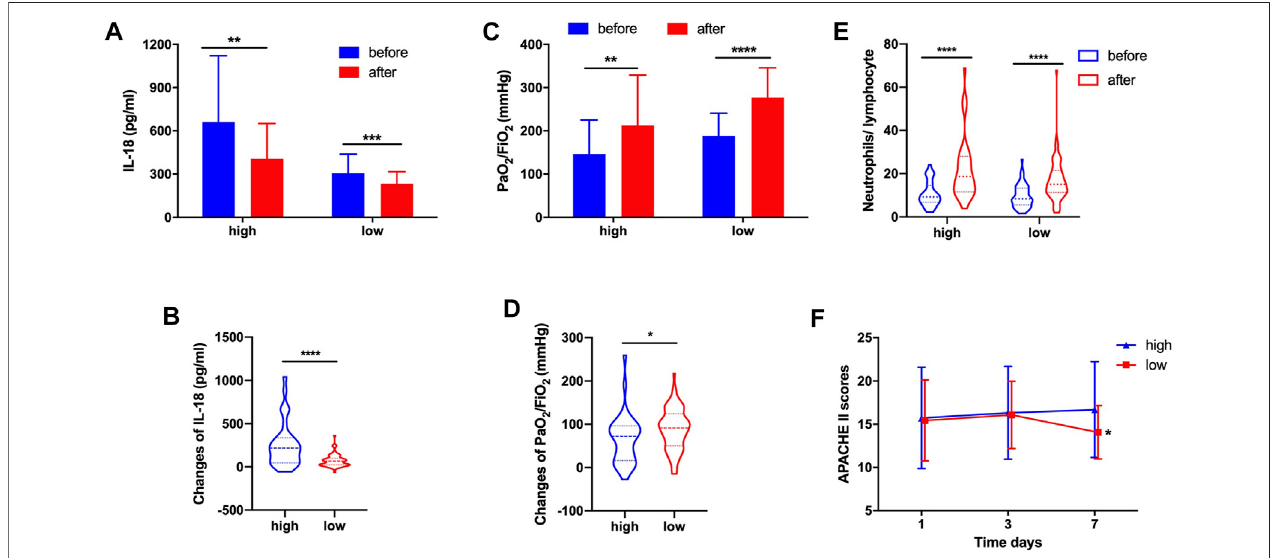
FIGURE 4 | In high-dose and low-dose groups, corticosteroid treatment decreased serum IL-18 (A) . Changes of IL-18 after corticosteroid treatment (B) . Corticosteroid treatment improved PaO 2 /FiO 2 (C) . Changes of PaO 2 /FiO 2 after corticosteroid treatment (D) . Corticosteroid treatment increased the neutrophil-to- lymphocyte ratio (E) . APACHE II score at day 1, day 3, and day 7 (F) .